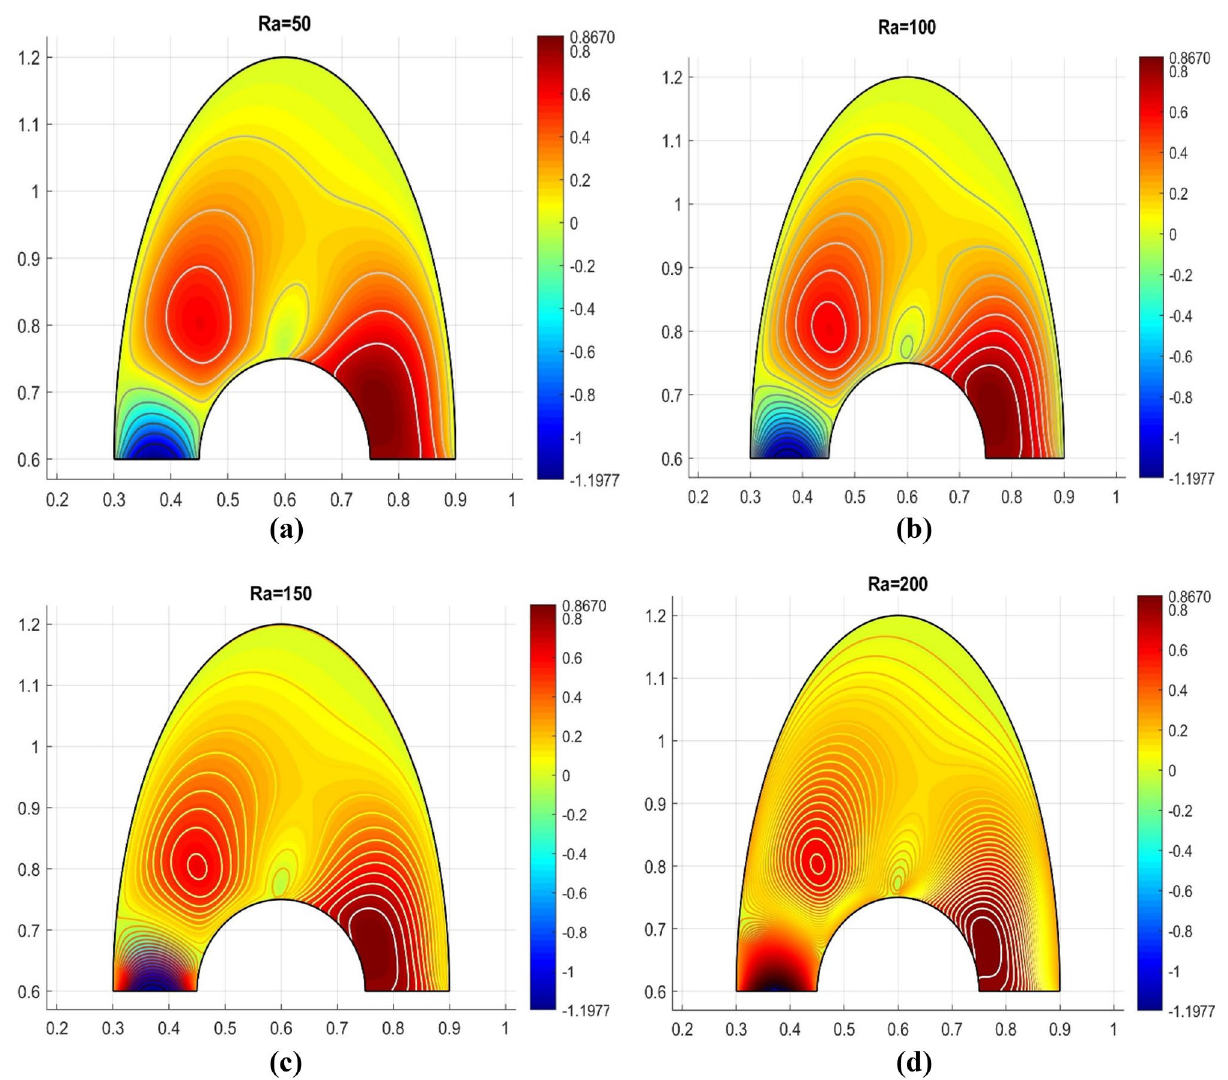
Figure 5. Various Rayleigh numbers for the velocity